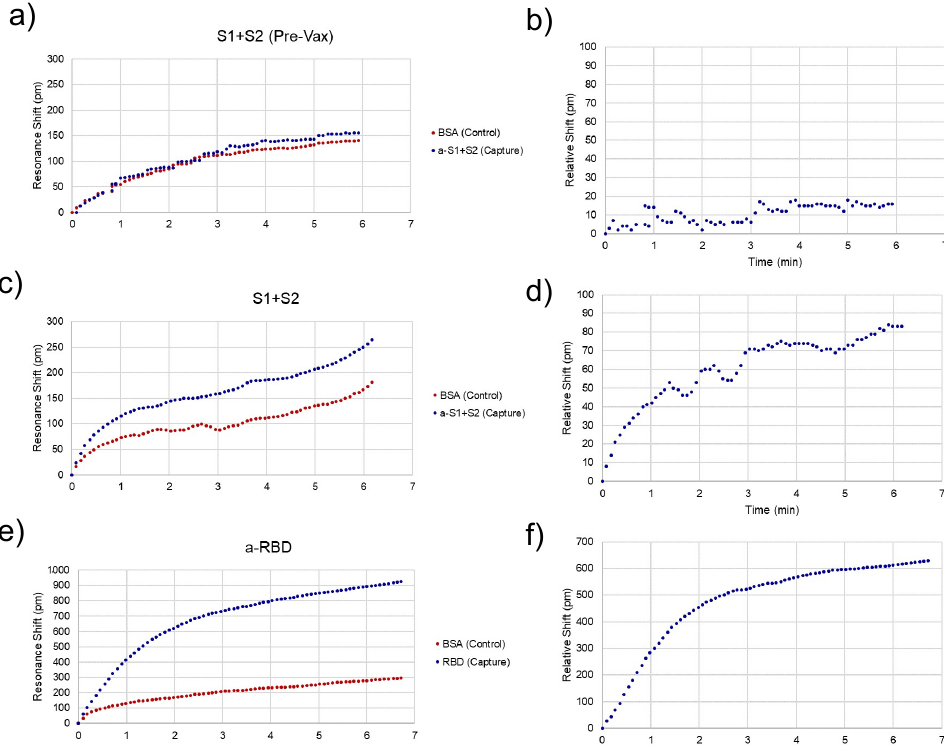
Figure 4. Assay Resonance Traces. Representative peak traces for chips sensing the presence of spike protein in unvaccinated ( a , b ) and recently vaccinated ( c , d ) subjects and anti-spike antibodies after the second dose. ( e , f ). ( a , c , e ) Each chip has a control (red) and capture (i.e., analyte-specific, blue) ring, whose resonance peaks are tracked over time. ( b , d , f ) The control ring is subtracted from the capture ring to give the relative shift, which is indicative of specific analyte binding. The relative shift at 3 min is what was recorded to compare between assays.